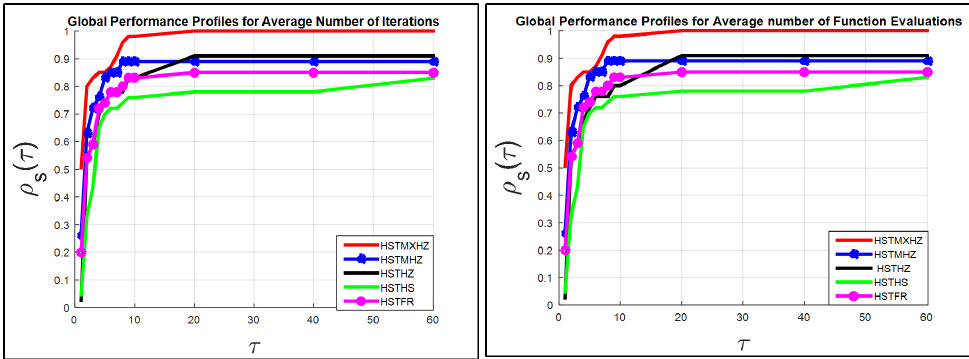
Figure 3. Average of CPU time performance profile.